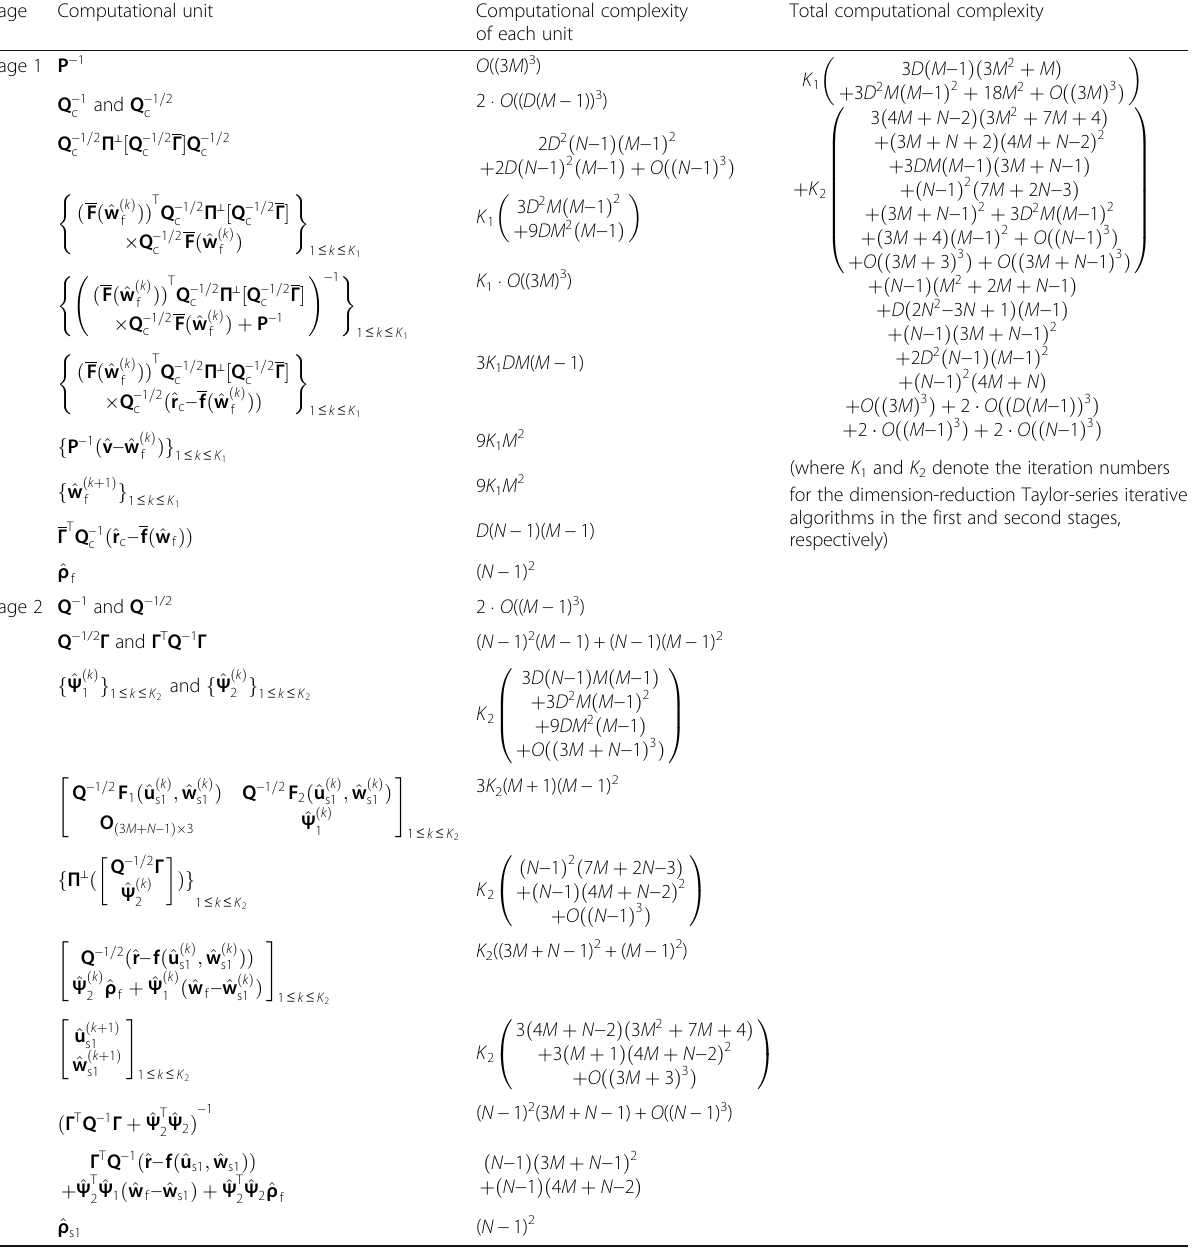
Table 6 Computational complexity of algorithm